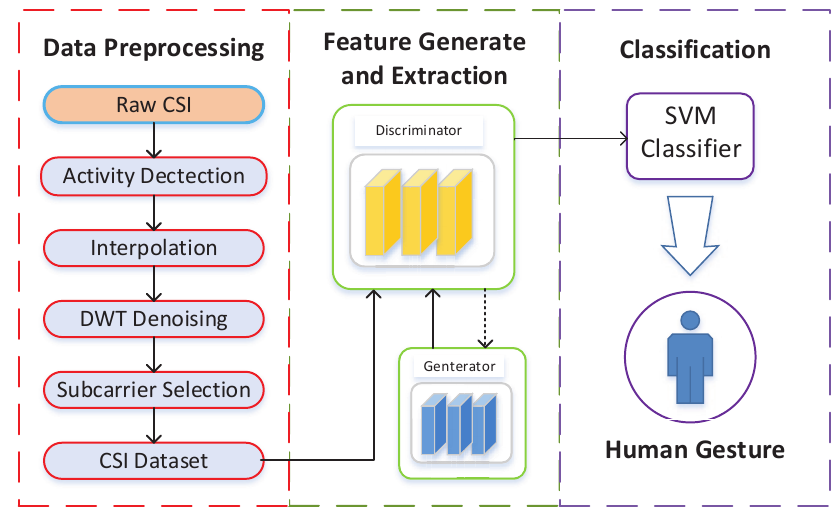
Figure 2. WiGAN system